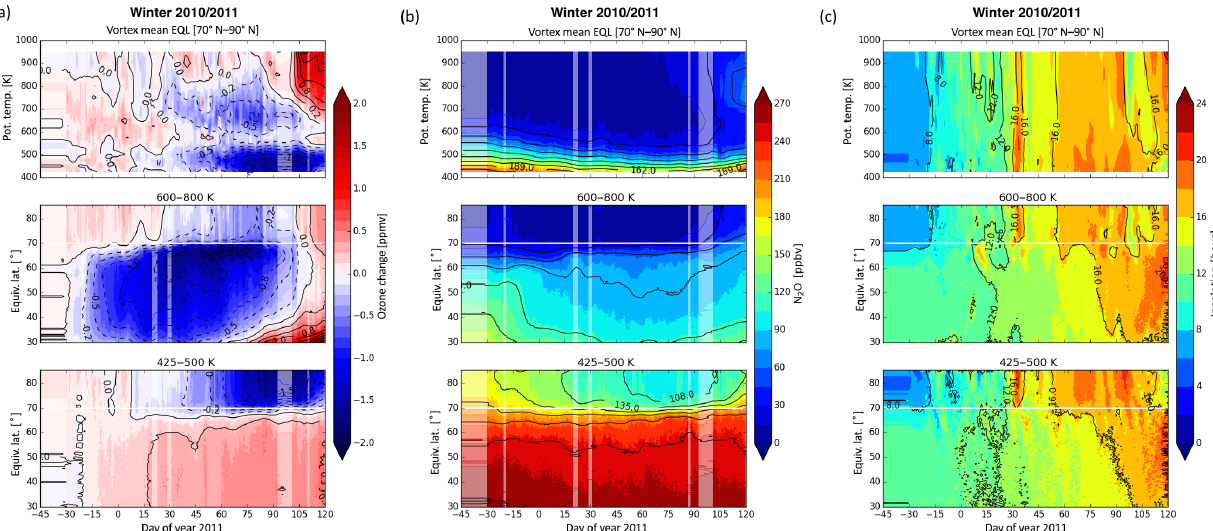
Figure 2. Chemical ozone change (left column, in ppmv), assimilated N 2 O volume mixing ratio (middle column, in ppbv) and the time change of cumulative insolation (right column, in hday − 1 ) during the Arctic winter 2010/11. The top panels of each column represent the vortex mean for each variable (70–90 ◦ N, EQL range) as a function of time and potential temperature. The two panels below show the temporal evolution of the spatial distribution in EQL at selected isentropic surfaces (the mid-stratospheric average between 600 and 800K and the lower stratospheric average between 425 and 500K, respectively). The horizontal white solid lines in these plots indicate the EQL of 70 ◦ N, used as the vortex edge border in our study. The shaded areas indicate the temporal gaps in the SMR O 3 and N 2 O data sets. The values shown during these periods correspond to the transport model